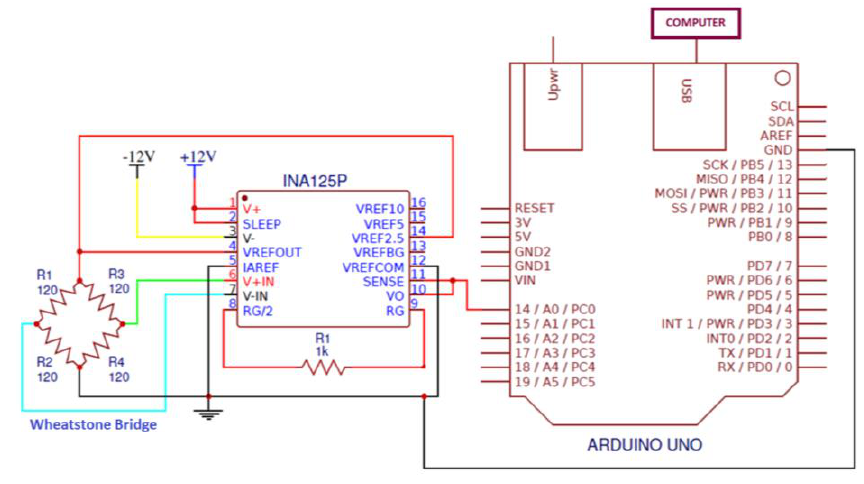
Figure 15. Calibration circuit.